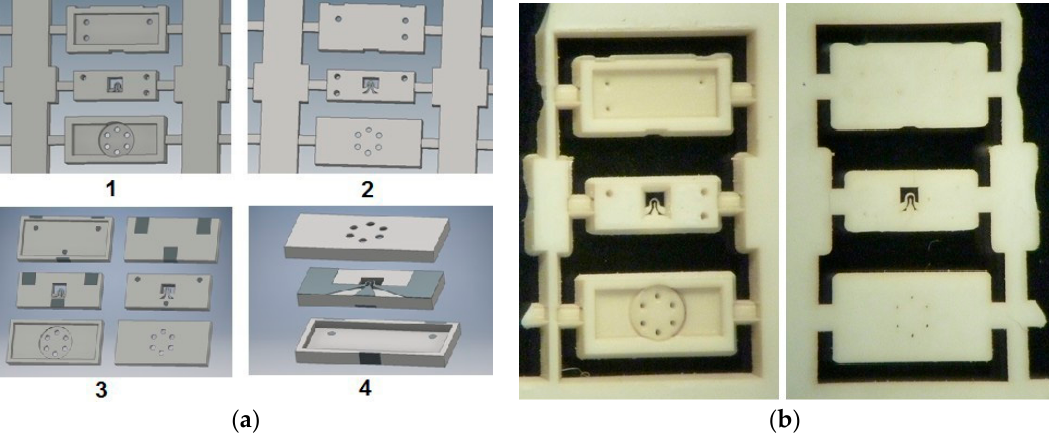
Figure 2. ( a ) 1—Bottom and 2—Top view of 3D model of microhotplate and parts of SMD package as a task for laser micromilling. 3—Scheme of metallization topology in 3D model. 4—Scheme of assembling MEMS microhotplate in SMD package; ( b ) Photos of bottom ( left ) and top ( right ) views on 250 µm thick Al 2 O 3 substrate with parts of SMD MOX gas sensor in SOT-23 package after laser micromilling. External dimension of SOT-23 package is 1.6 × 2.8